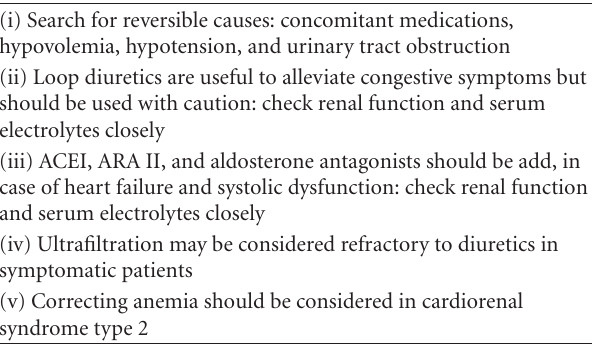
Table 2: Summary of recommendations for clinical